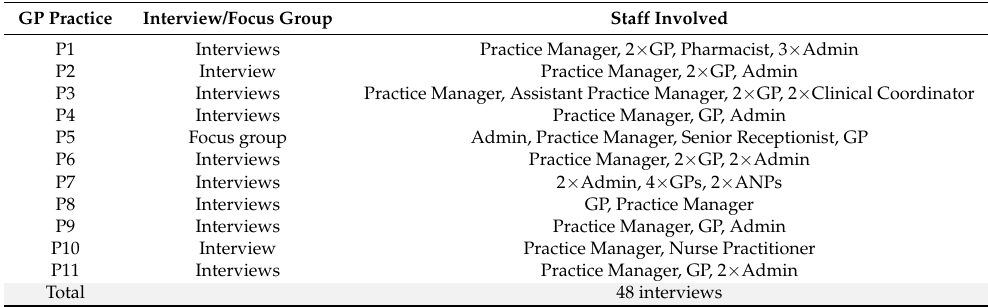
Table 1. Complement of staff interviewed across 11 GP